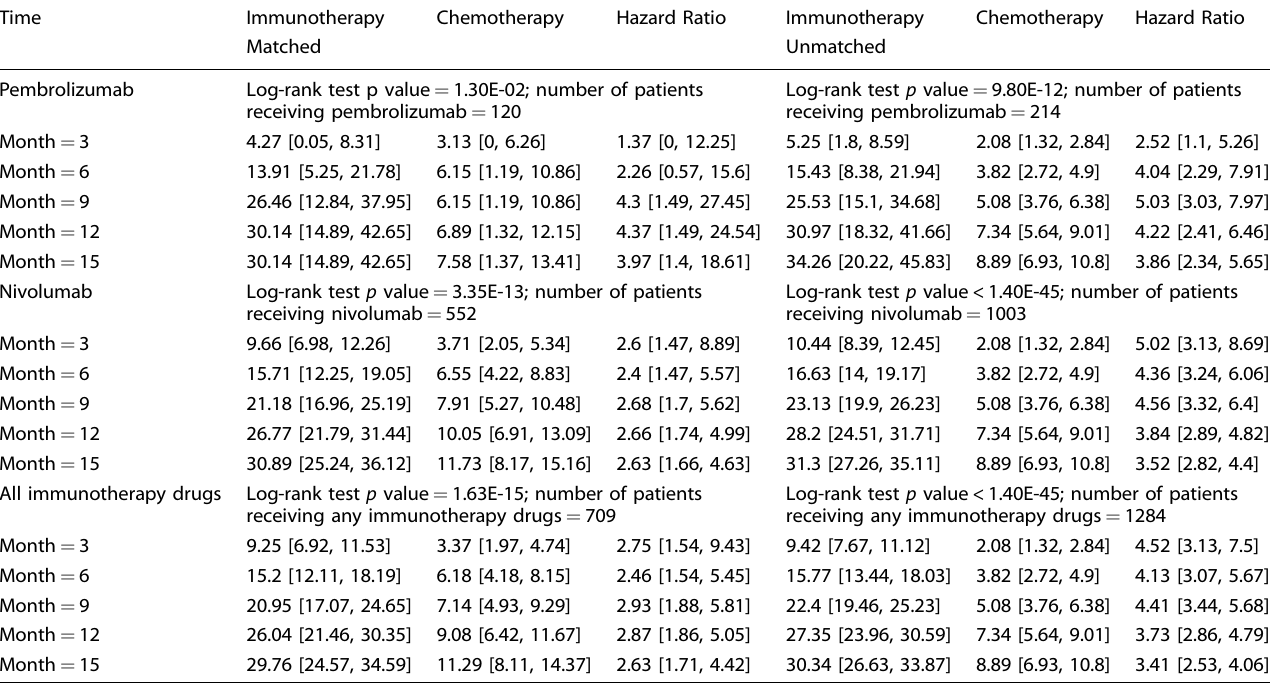
Table 2. The cumulative incidence rate (%) of irAEs of the immunotherapy and the chemotherapy groups in the renal cancer cohort as well as the hazard ratios between